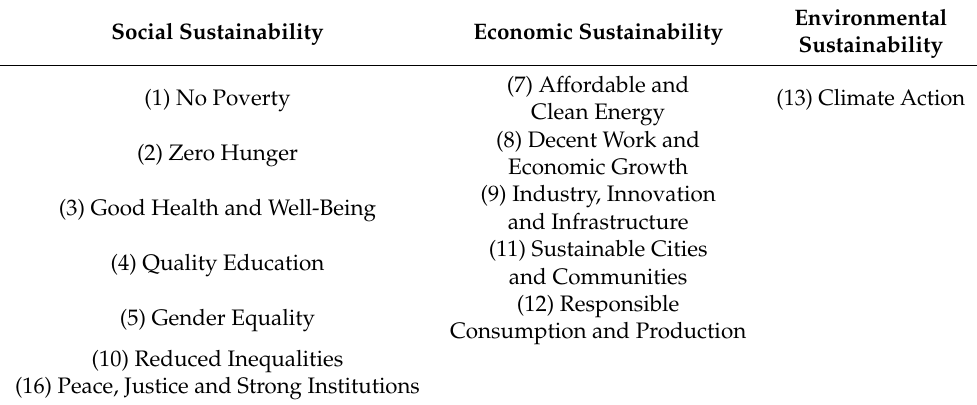
Table 1. SDGs in use per